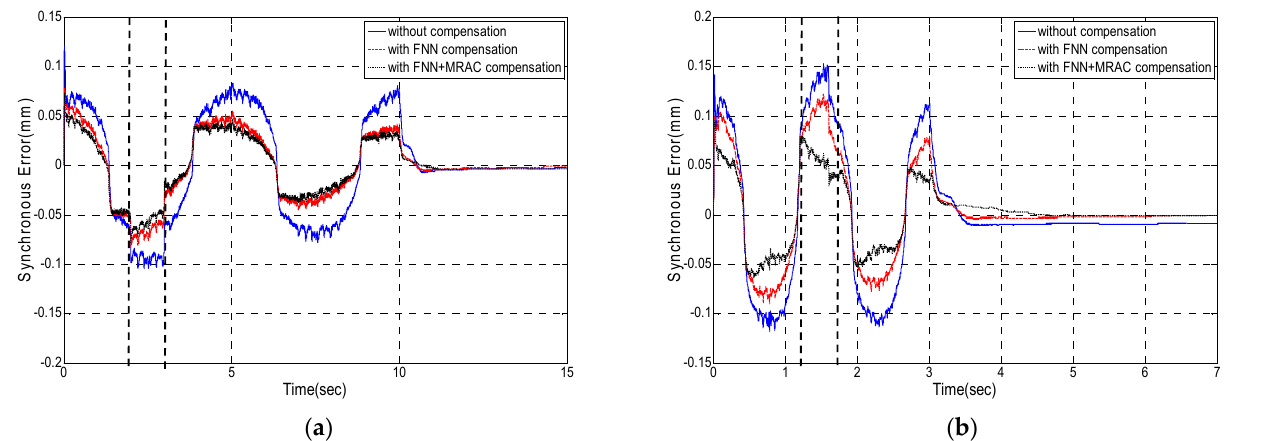
high-frequency commands.